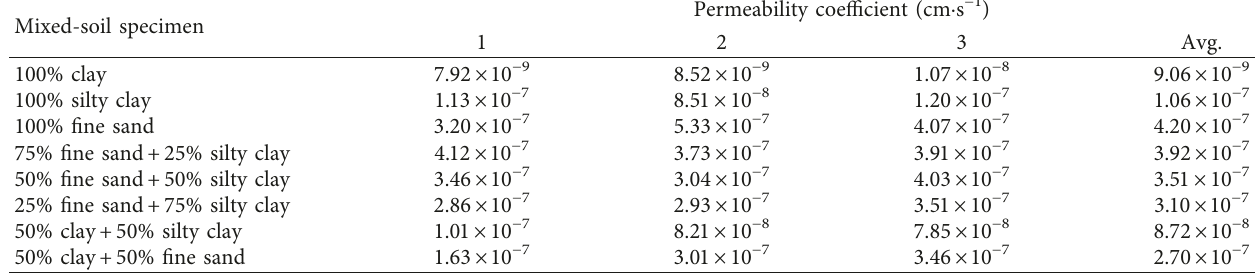
Table 8: Permeability coefficient of mixed-soil cement.